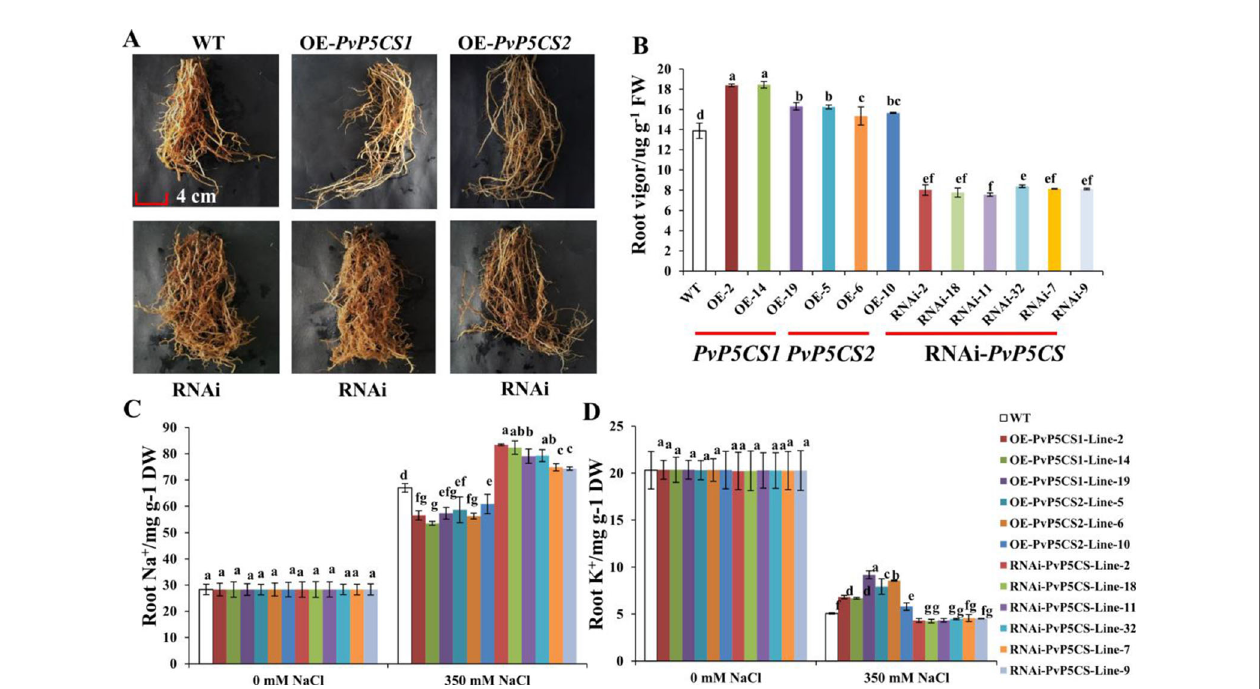
FIGURE 5 | Phenotype and ion (Na + and K + ) contents of roots in PvP5CS OE and RNAi transgenic plants under salt stress. Phenotype of roots in PvP5CS OE and RNAi transgenic plants under 350 mM NaCl salt stress (A) . Root vigor in PvP5CS OE and RNAi transgenic plants under 350 mM NaCl salt stress (B) . Na + (C) and K + (D) contents of roots in PvP5CS OE and RNAi transgenic plants under 350 mM NaCl salt stress. Data are mean values of three biological repeat, and signi fi cance of treatments was tested at the P < 0.05 level (one way ANOVA, Dunnett's